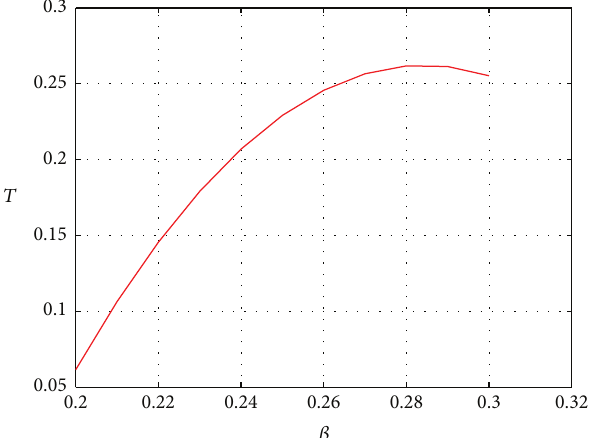
Figure 3: Diagram of the transferring payment in 𝛽 .